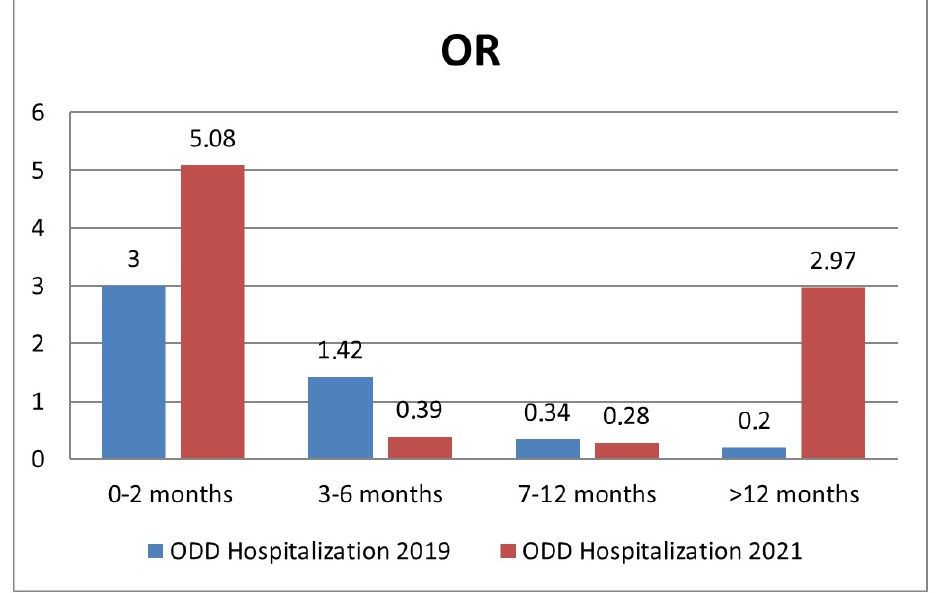
Figure 4. Risk of hospitalization by age group in 2021 compared to 2019.